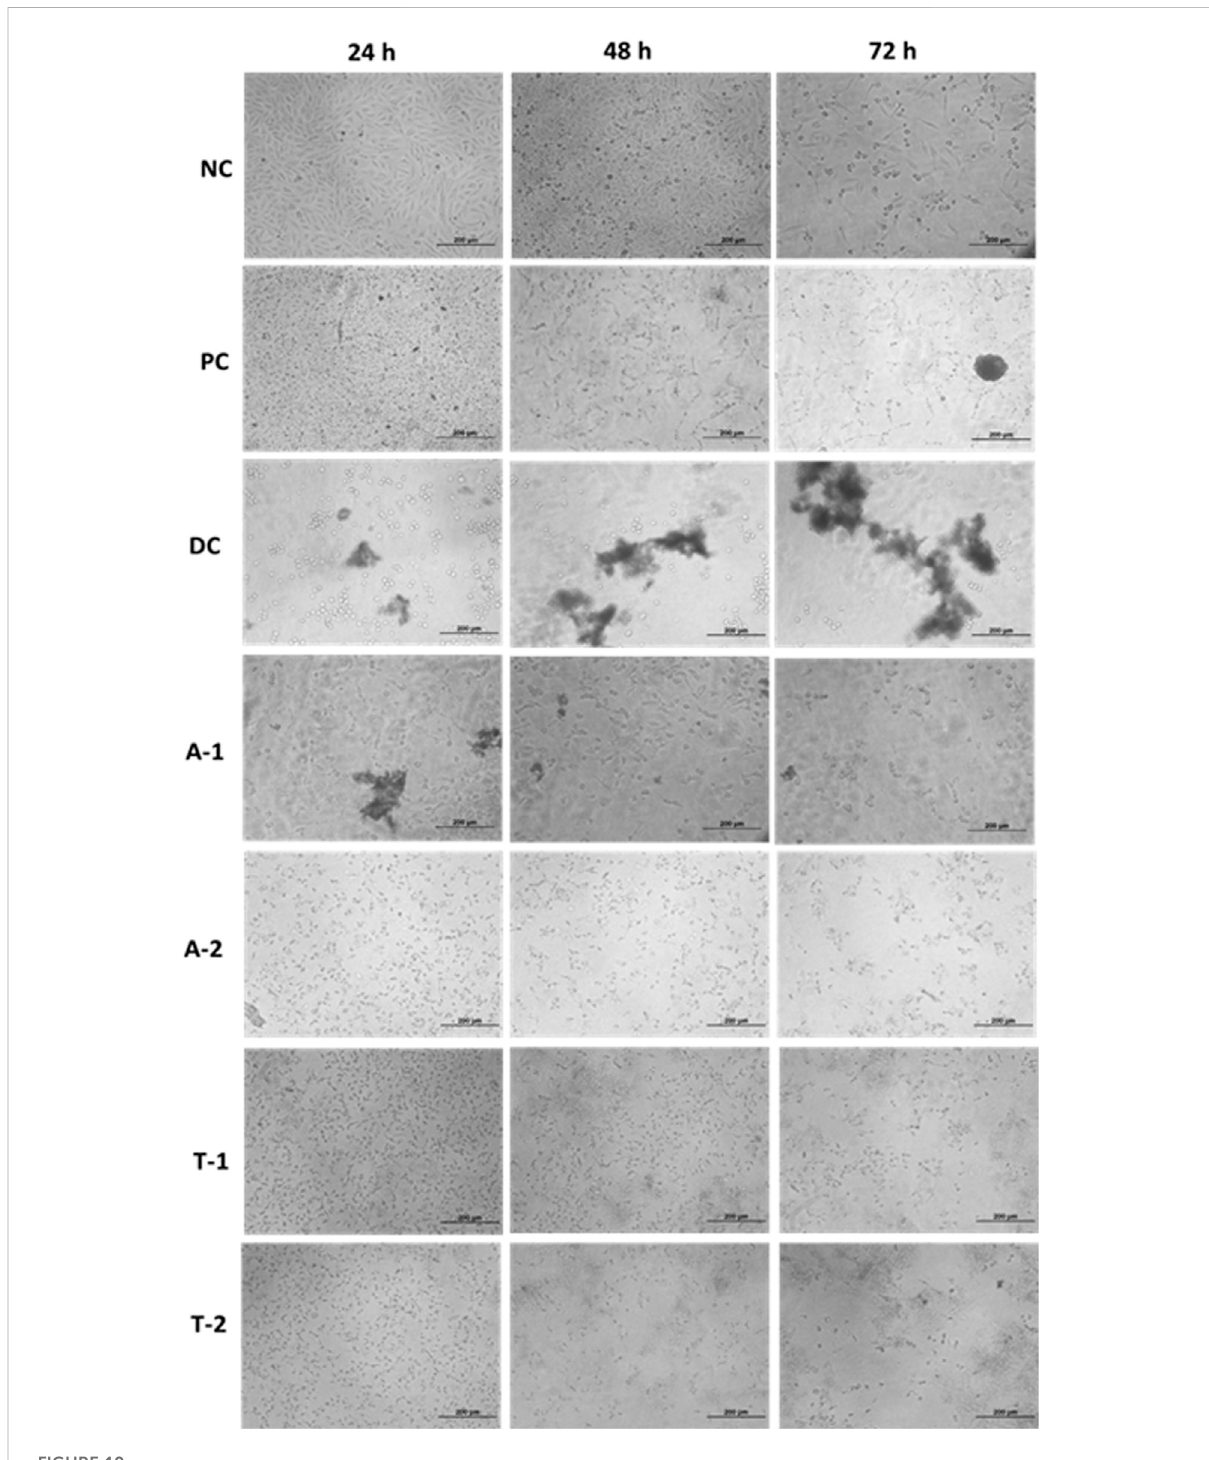
FIGURE 10 Microscopic data showing inhibition in cell proliferation over